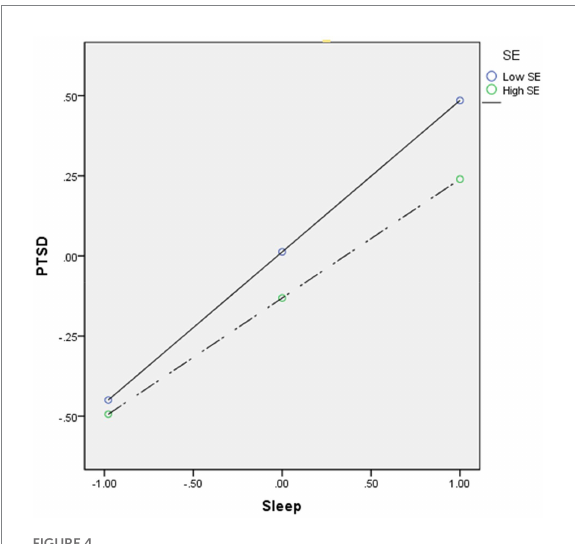
FIGURE 4 Moderation effect of self-esteem between sleep disturbance and PTSD. High and low levels of self-esteem represent one standard deviation above and below the mean. SE, self-esteem; PTSD, posttraumatic stress